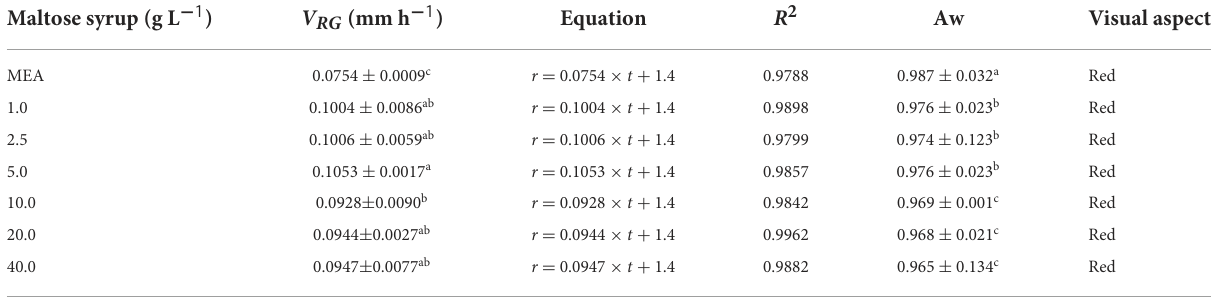
TABLE 2 Radial growth rate (V RG ), equation of the colonies radius as a function of cultivation time, coefficient of determination (R 2 ), water activity (Aw) and visual colour aspect of the colonies of Monascus ruber CCT 3802 grown in different concentrations of maltose syrup. − 1 − 1 Maltose syrup (g L ) V RG (mm h ) Equation R 2 Aw Visual aspect